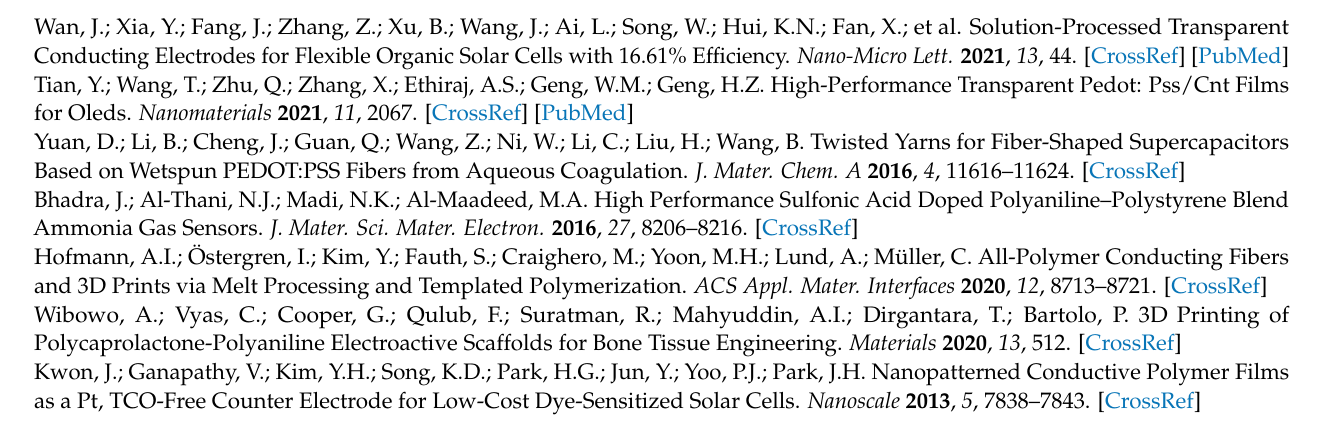
Figure S3: The 1 H NMR spectrum of synthesized acceptor Ma-A monomer; Figure S4: The 13 C NMR spectrum of synthesized acceptor Ma-A monomer; Figure S5: The IR transmittance spectra of synthe- sized donor and acceptor monomers, as well as the polymer brushes obtained via surface-initiated RAFT polymerization; Figure S6: The XPS spectrum of (A) poly( St-D - alt - Ma-A ) brushes obtained via RAFT polymerization and (B) sulfur region; Figure S7: Exemplary spectroscopic ellipsometry data for the polymer brushes obtained via RAFT polymerization (A) and their fits to the Cauchy model (B); Figure S8: AFM pictures of poly( St-D - alt - Ma-A ) brushes obtained via RAFT polymerization with various grafting densities: (A) 100% (B) 80% and (C) 70%; Figure S9: The IR transmittance spectra (3500–1300 cm − 1 ) of poly( St-D - alt - Ma-A ) brushes obtained via RAFT and metal-free ATRP (the spec- tra at wavenumbers below 1300 cm − 1 contain some artefacts related to the ITO substrates and are not comparable); Figure S10: The relationship between thickness of donor-acceptor poly( St-D - alt - Ma-A ) brushes and time of metal-free ATRP polymerization; Figure S11: UV-Vis absorption spectra of the monomers used to synthesis of donor-acceptor polymer brushes. Solutions of both compounds are prepared in dioxane; Table S1: Thickness of donor-acceptor brushes obtained during various time of metal-free ATRP